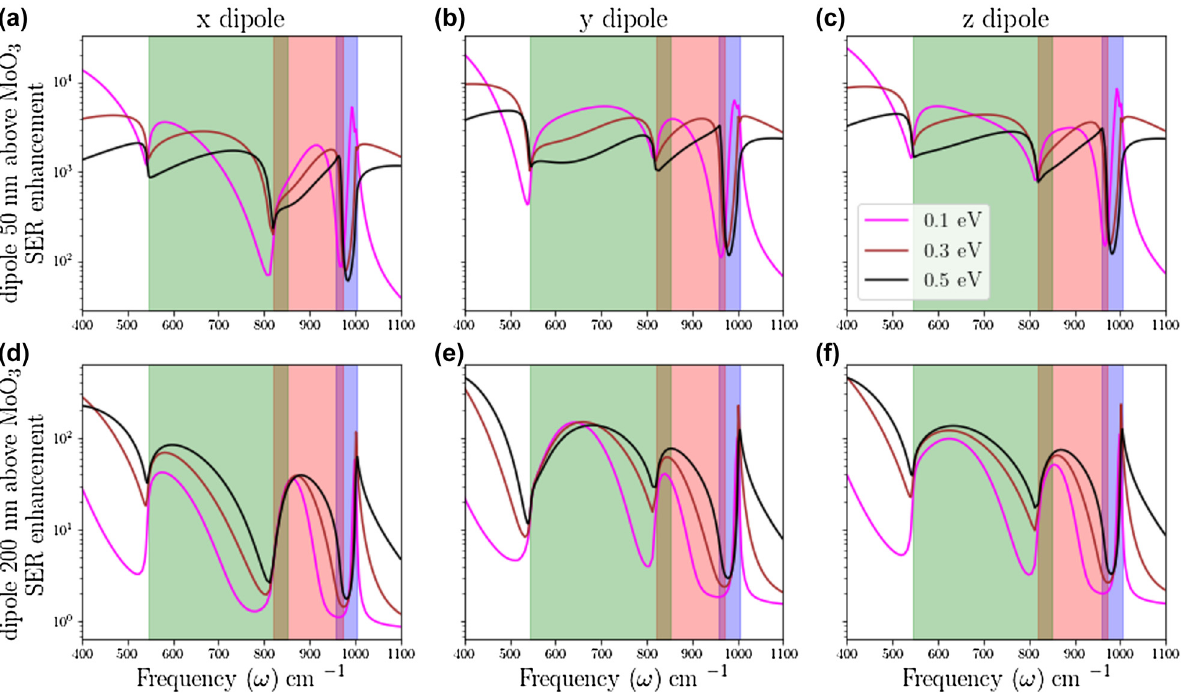
Figure 4: Anisotropic spontaneous emission rates for dipole placed above air/graphene/ α -MoO 3 (50 nm)/Si heterostructure: (a) – (c) represent SER enhancements at different μ values for x -, y -and z -polarized electric dipole, respectively, at z 0 = 50 nm. (d) – (f) represent SER enhancements at different μ values for x -, y - and z -polarized electric dipole, respectively, at z 0 = 200 nm. The green, red and blue shaded regions represent the RB-1, RB-2, and RB-3 spectral regions of α -MoO 3 ,